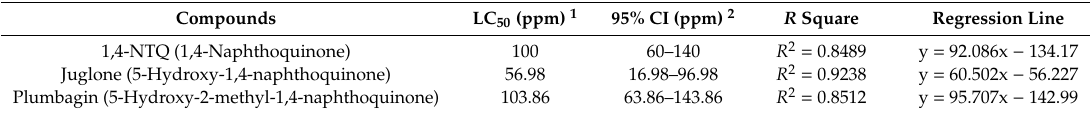
Table 1. The median lethal concentration (LC 50 ) values of naphthoquinones against Bursaphelenchus xylophilus mixed development stages in vitro at 48 h after exposure to 1,4-naphthoquinone, juglone, and plumbagin.